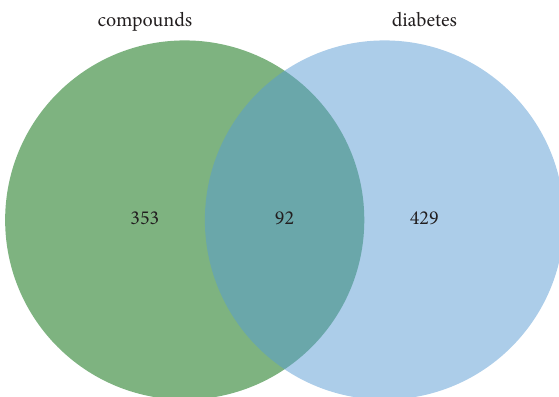
Figure 2: Overlapping genes of diabetes and compound